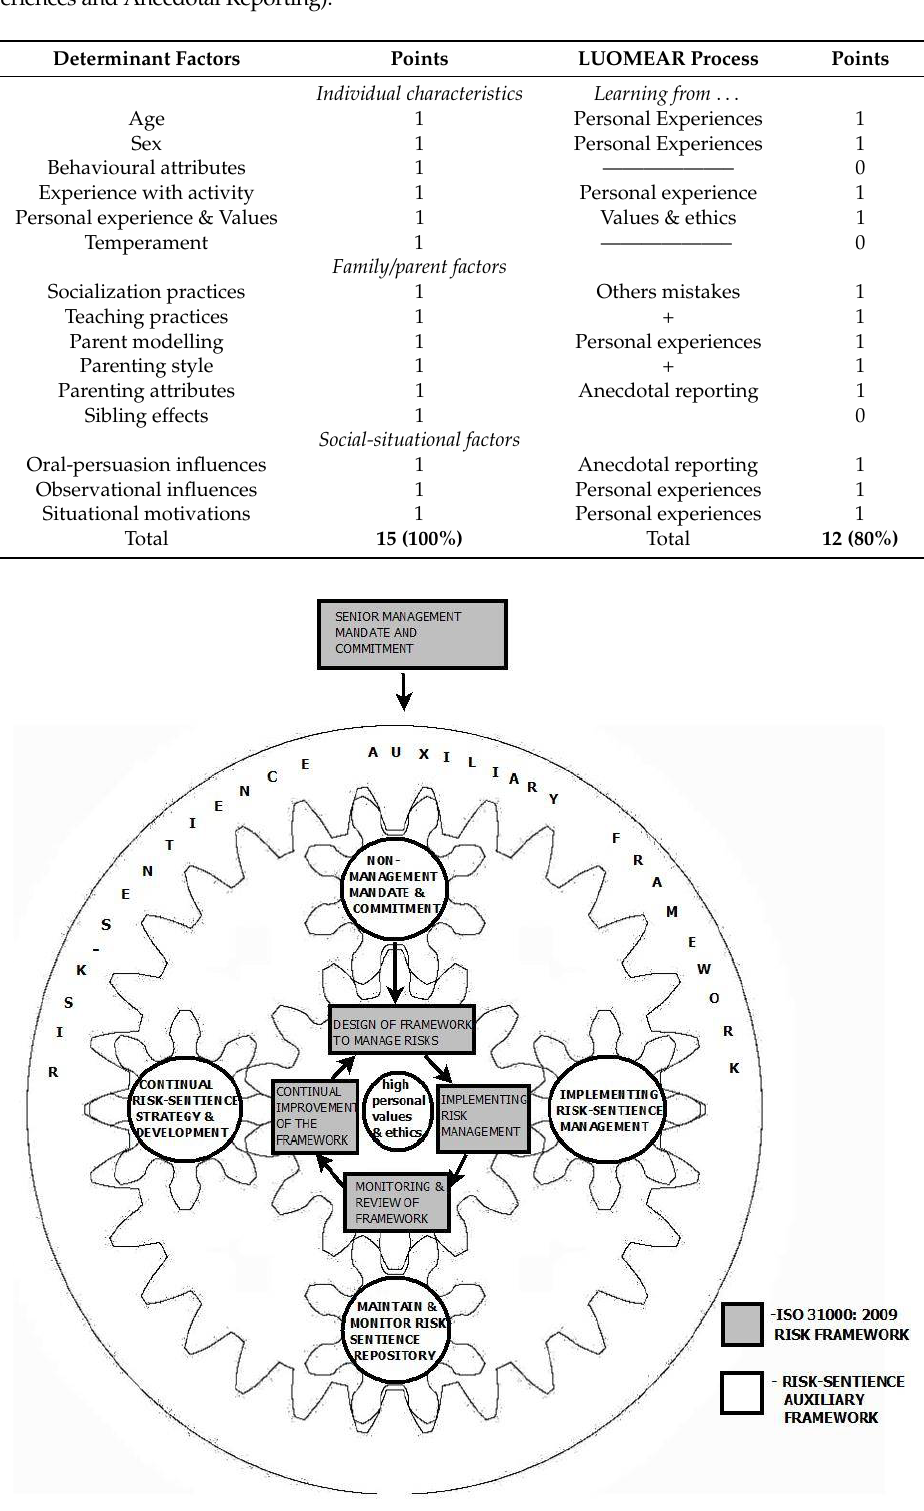
Figure 1. Risk-Sentience Auxiliary Framework.